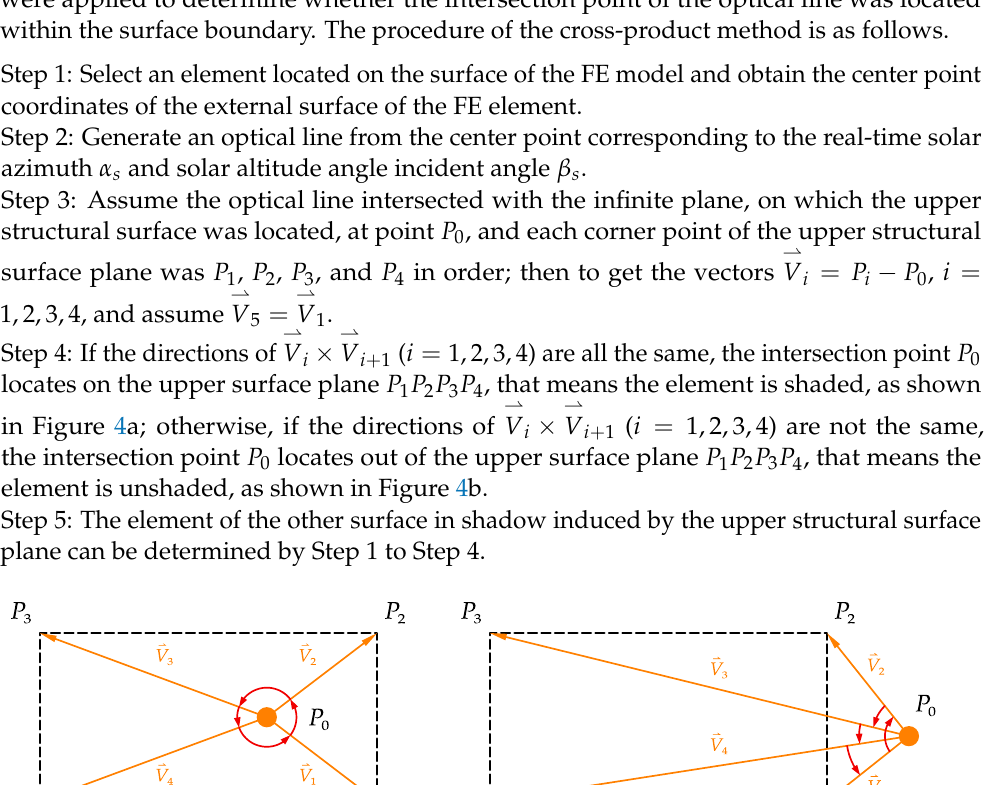
Figure 4. Schematic diagram of the cross-product method. ( a ) The point P 0 is on the plane P 1 P 2 P 3 P 4 ; ( b ) the point P 0 is out of the plane P 1 P 2 P 3 P 4 .